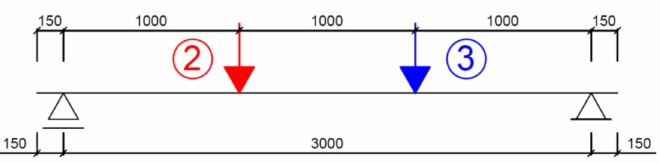
Figure 5. Static scheme of beams A2, D2 and